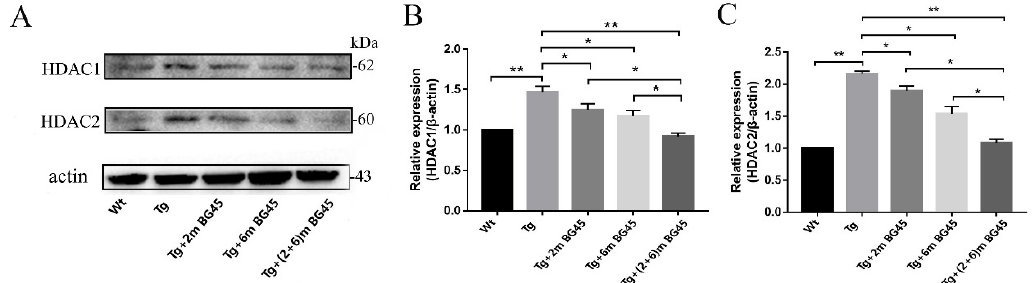
Figure 9. BG45 reduced HDAC1 and HDAC2 protein expression in hippocampal neurons from APP/PS1 mice ( n = 5). ( A ) Immunoblot analysis of levels of the HDAC1 and HDAC2 proteins in the hippocampus of mice treated with vehicle or BG45. ( B ) Quantification of the HDAC1 levels. ( C ) Quantification of the HDAC2 levels. Significant differences were determined using one-way ANOVA. All values are presented as the means ± SD from three independent experiments. * p < 0.05, ** p < 0.01, n = 5 mice per group.